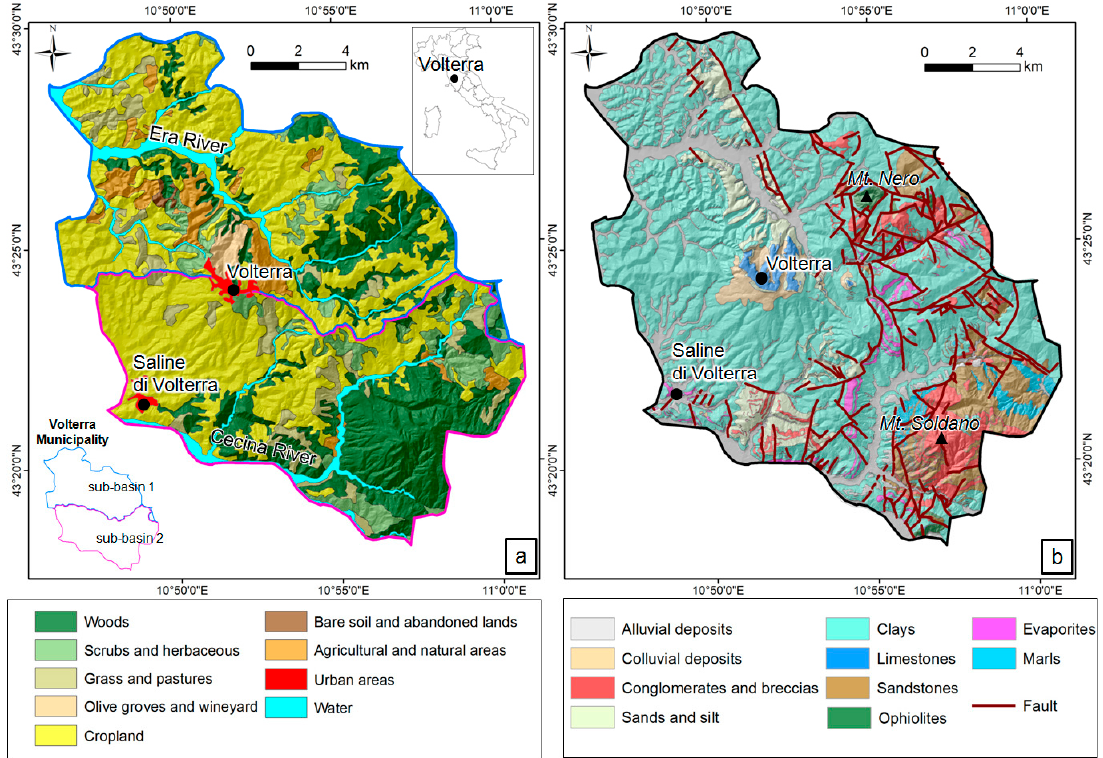
Figure 2. Environmental setting of the Volterra study area: ( a ) location of the Volterra municipality, sub-basins division and land cover map derived from Corine Land Cover map; and ( b ) geological map at the scale 1:50,000 from the Italian CARG Project [39]. Background layer is a DEM (Digital Elevation Model) with 20 m cell size extracted from TINITALY/01 DEM Project [40].